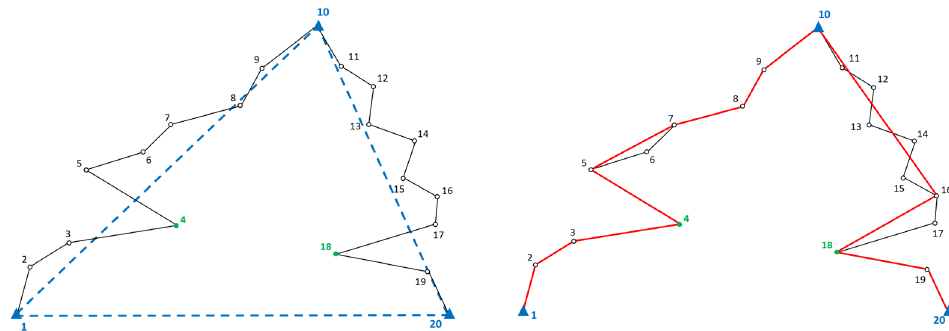
Fig. 2. Ordered polyline L u with cartographic control points W 1 , W 10 , W 20 : a) base triangle BT (blue) and identified singular vertices W 4 and W 18 (green); b) polyline, simplified to a scale of 1:20,000